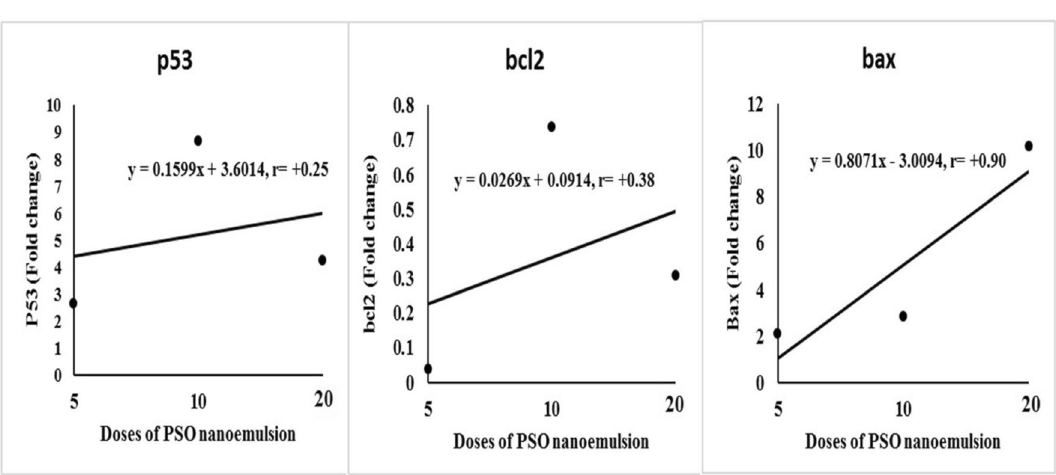
Figure 9. Regression analysis to illustrate the relationship between the different doses of PSO nano-emulsion and the expression levels of the studied p53, Bcl2 and Bax genes. r: Pearson’s correlation